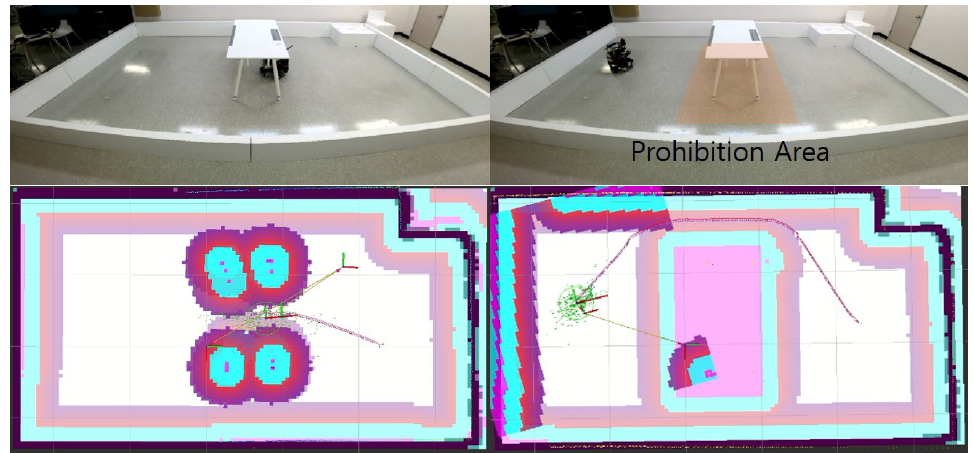
Figure 4. Comparison of the non-prohibition filters in the left and right sides.